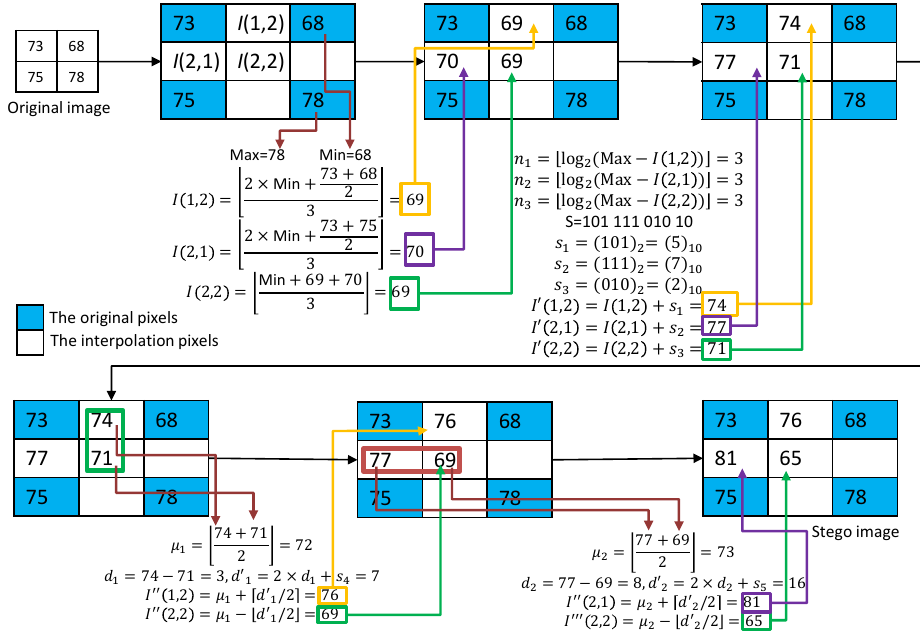
Figure 2. An example of the MN interpolation and the data embedding with the DIM and DE methods.